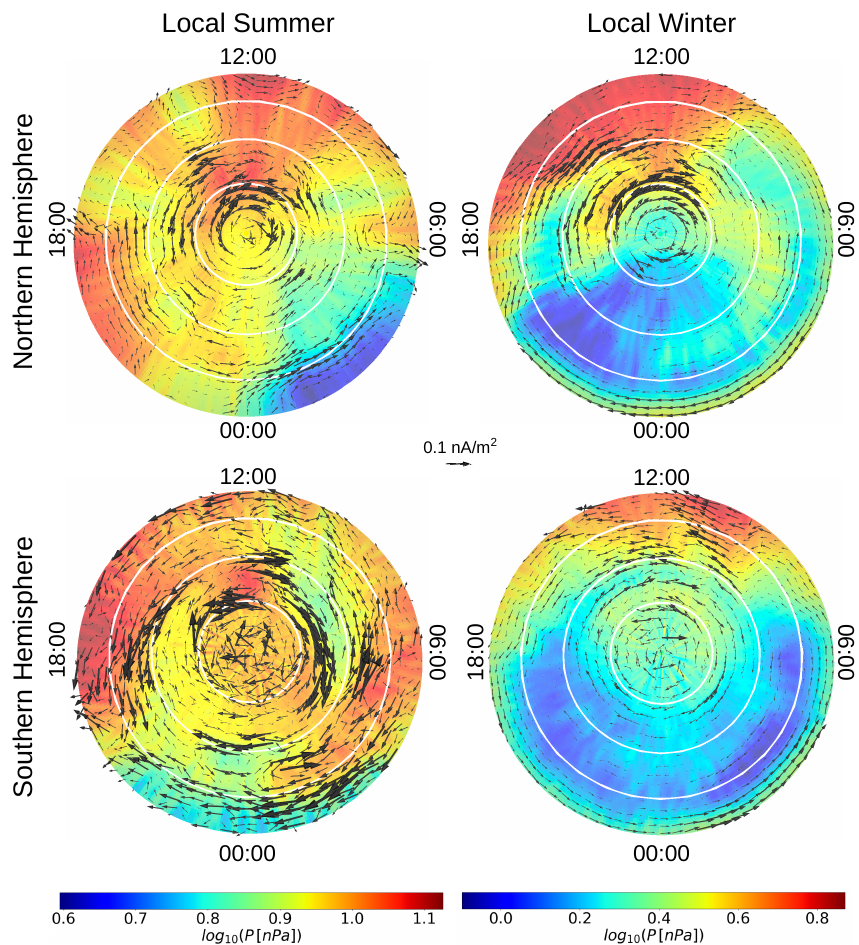
Figure 7. Flow patterns of pressure-gradient current (black arrows) superimposed on the plasma pressure distribution during summer ( left column) and winter ( right column) periods, in the Northern and Southern hemispheres. Maps are in QD-latitude ( λ QD > | 50 ◦ | ) and MLT reference system. The binning window is 1 ◦ λ QD × 4 (cid:48) MLT for the pressure map, while for the current’s vector field the window is 2 ◦ λ QD × 16 (cid:48) MLT for graphical reasons. The concentric white circles are plotted in 10 ◦ interval, corresponding to QD-latitudes of | 80 ◦ | , | 70 ◦ | and | 60 ◦ | starting from the